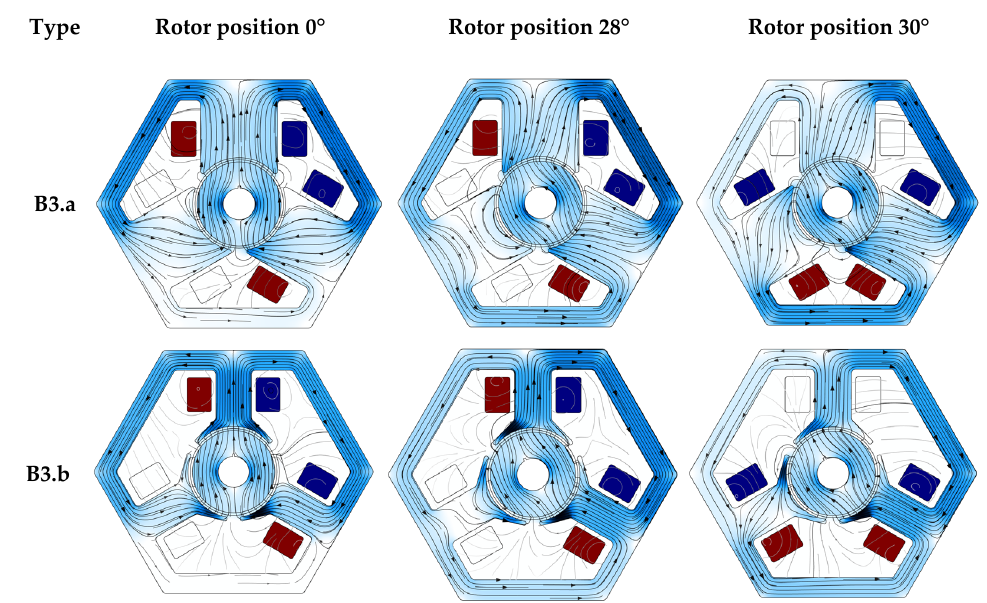
Figure 12. Examples: magnetic flux density and magnetic vector potential (lines). The position of the rotor in the subsequent drawings is 0, 28 and 30 degrees after the change of power bands, models B3.a and B3.b.